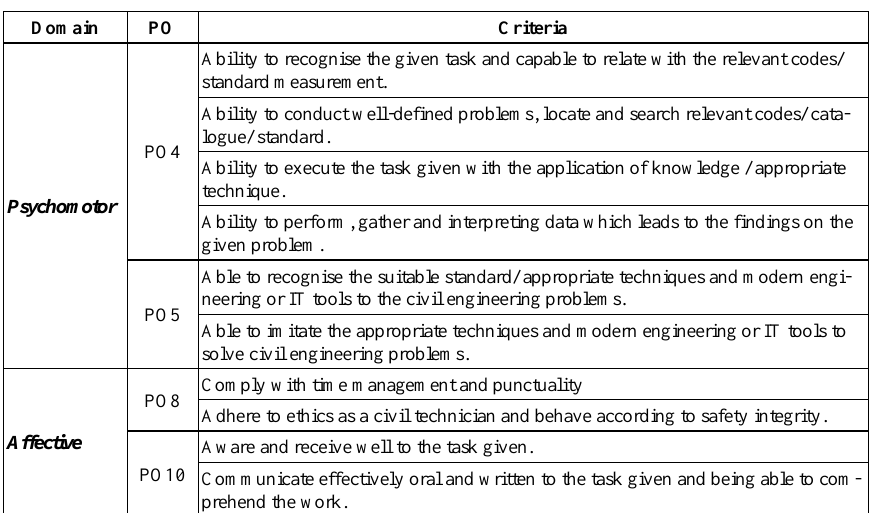
Table 4. Evaluation